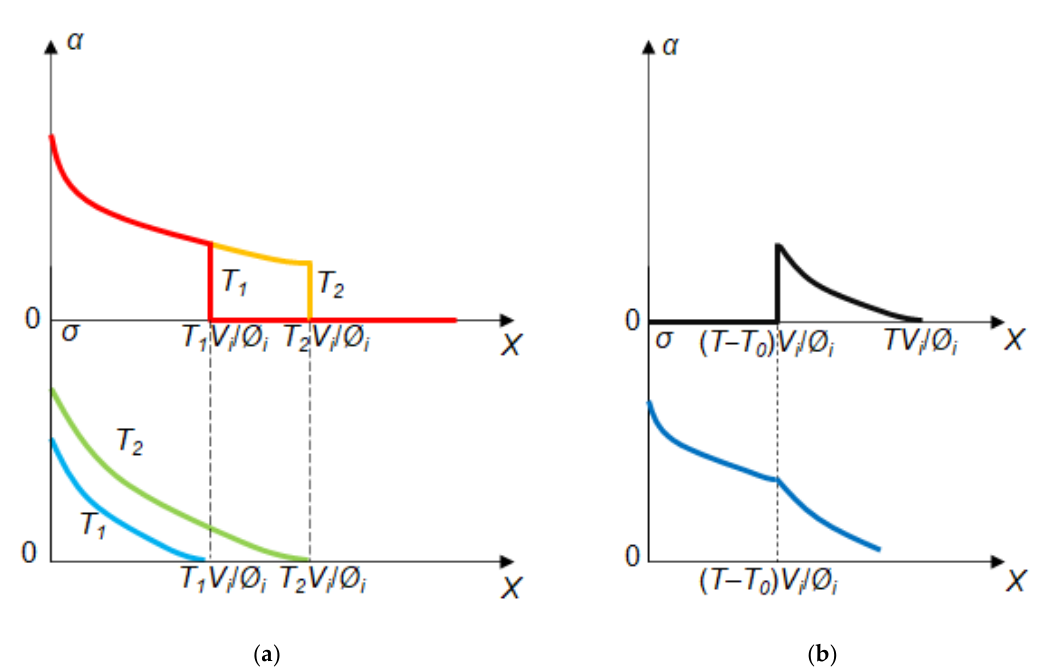
Figure 2. Distribution of suspended and trapped particles in three time moments: ( a ) During suspension injection for dimensionless time moments T 1 and T 2 ; ( b ) during suspension slug displacement by water.